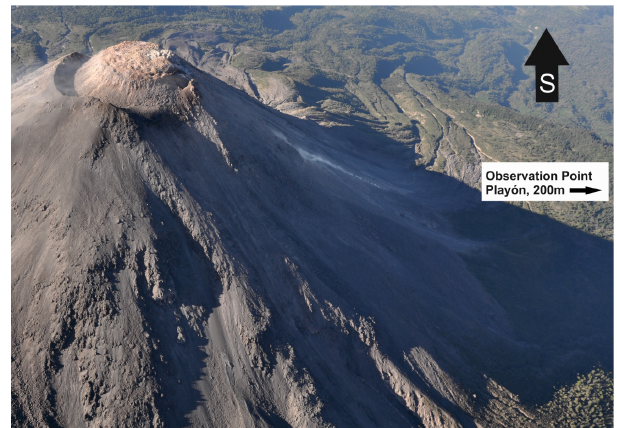
Fig. 2. Photograph shows Volc´an de Colima and the location of the observation camp within the Play´on to the west of the volcano. The image shows the decentralized growing dome of Volc ´ an de Colima. The dome has a diameter of 298m and can be used as a scale. The white dust track down the slope was triggered by a recent